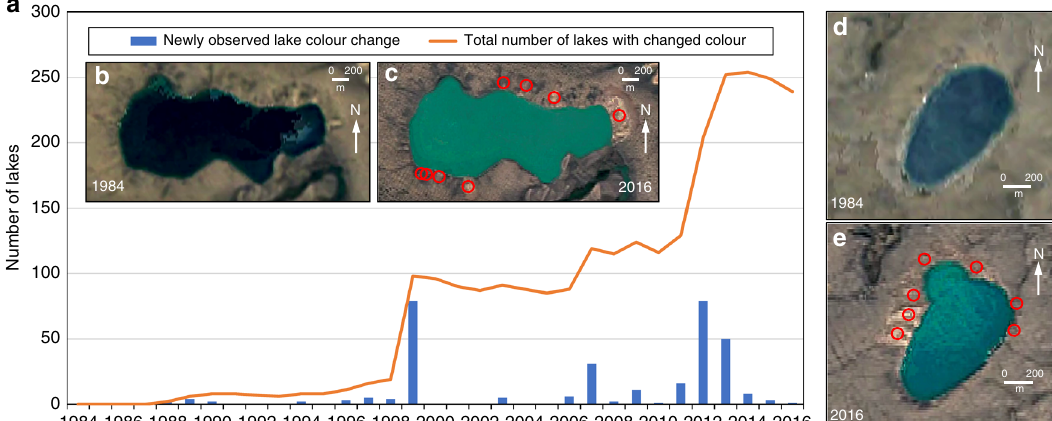
Fig. 7 Lake colour change due to retrogressive thaw slump activity. a Annually resolved time series of numbers of lakes visually changing colour (from dark blue to turquoise or beige) observed for Banks Island (1984 – 2016) using Timelapse. b , c Individual lake colour change from 1984 to 2016 due to retrogressive thaw slumps becoming active around the shoreline (73.08°N 117.67°W). d , e Example of the development of a new bay in a lake due to retrogressive thaw slump activity (71.65°N 121.91°W). More than 200 m of shoreline recession occurred from 2000 – 2016. Red circles in ( c and e ) are locations of retrogressive thaw slumps which became active during the Timelapse